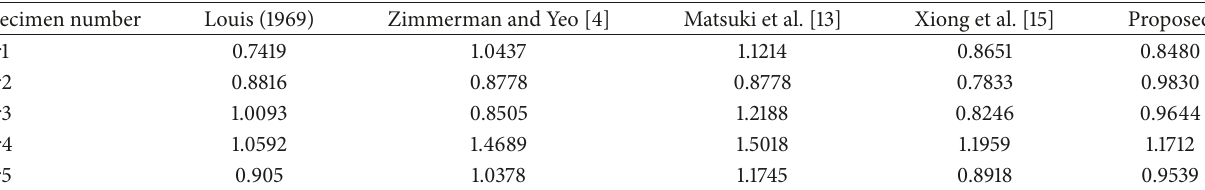
Table 4: Evaluation of hydraulic aperture model using the 𝛾